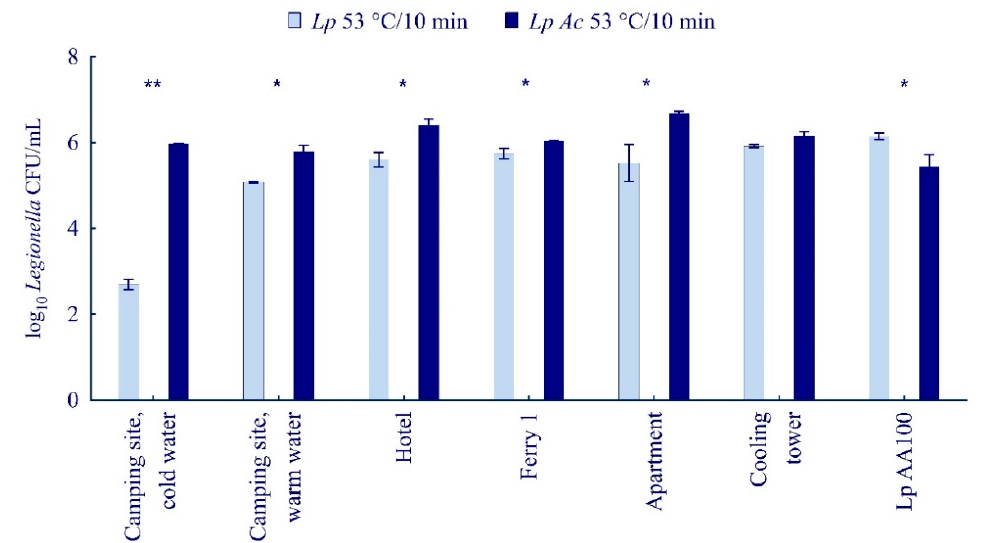
Figure 7. The number of Legionella CFU of agar-grown L. pneumophila ( Lp ) and A. castellanii -grown L. pneumophila ( Lp AC) samples after pasteurization treatment at 53 °C for 10 min. L. pneumophila AA100 was used as the control organism. Student’s t- test, * p < 0.05, ** p < 0.01 were accepted as significantly different from control sample.